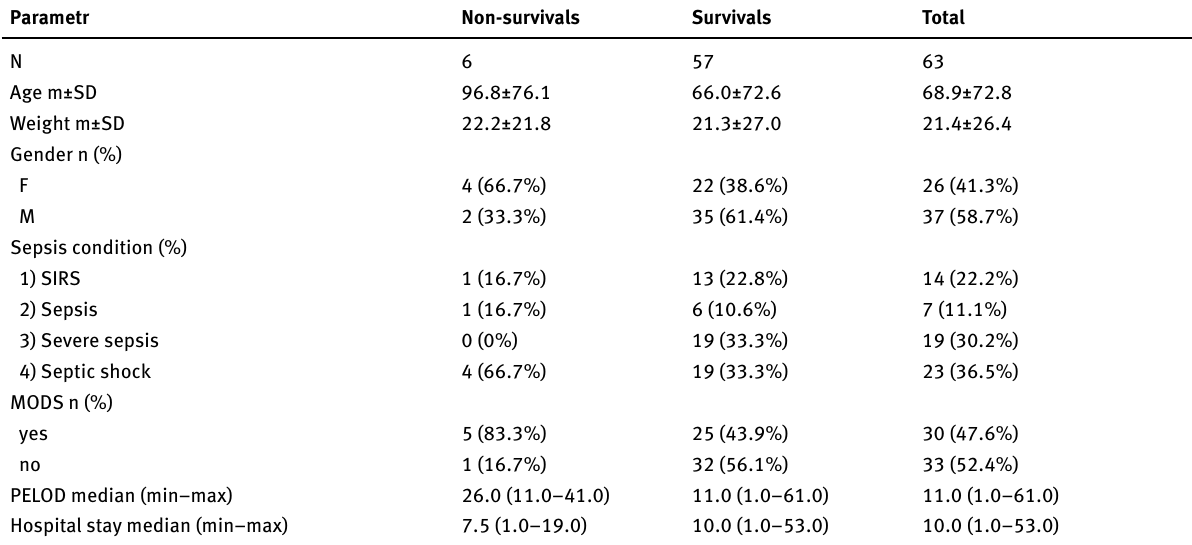
Table 1: Sample characteristics